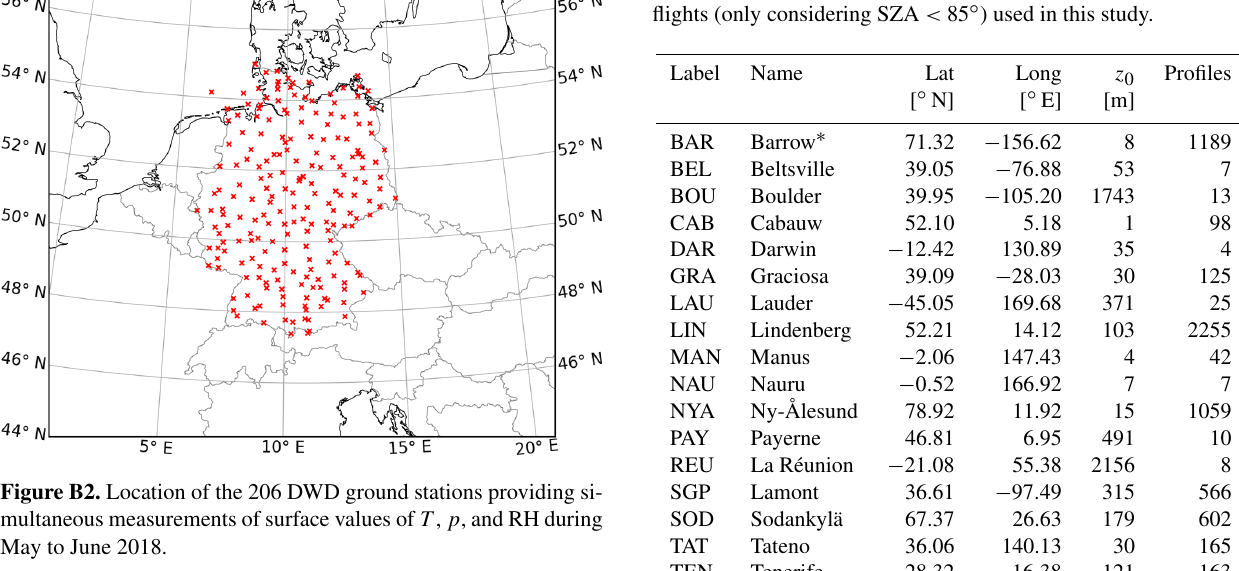
Table B1. List of GRUAN stations and number of available sonde flights (only considering SZA < 85 ◦ ) used in this